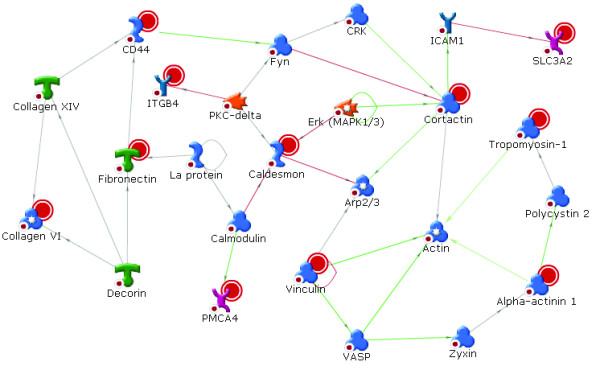
Network containing products of alternatively spliced genes in colon cancer. Proteins affected by alternative splicing are indicated with a red disk. Proteins concerned with cell or matrix adhesion are generally to the left while those concerned with cell motility and the actin cytoskeleton occupy the center and right. "PMCA4" is an alias for ATP2B4.